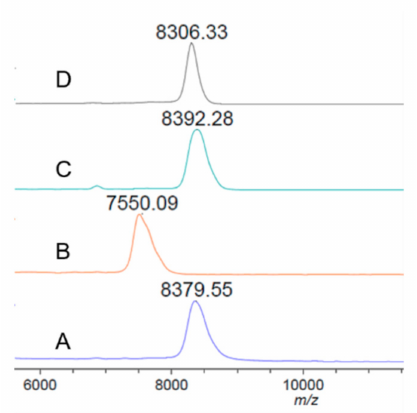
Figure 3. MALDI-TOF MS results for the enzymatic hydrolysis of ( A ) human C5a peptide (30 µ g/mL) catalyzed by ( B ) rsScpA (1.0 µ g/mL), ( C ) rsScpA193 (300 µ g/mL) and ( D ) Cat (300 µ g/mL) after incubation at 20 ◦ C for 30